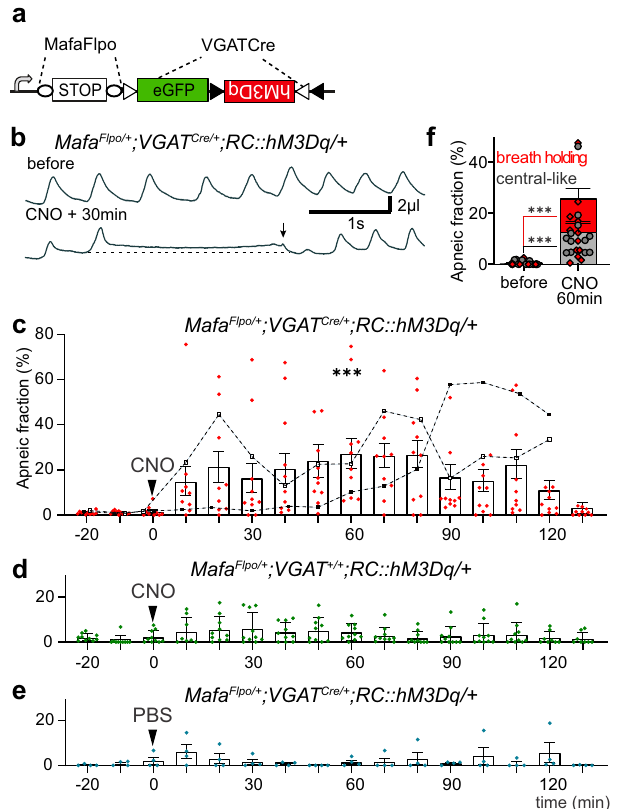
Fig. 6 Chemogenic activation of Mafa inhibitory neurons triggers apneas. a Genetic scheme to introduce the hM3Dq DREADD in Mafa + inhibitory neurons. b Plethysmographic traces of the ventilation of a P1 Mafa Flpo/ + ; VGAT Cre/ + ; RC::hM3Dq/ + pups before (top) and 30 min after a subcutaneous injection of CNO (5 mg/kg). Note the presence of a click-like upward pressure shift terminating the breath holding apnea. c Injection of CNO in P1-2 mutants caused a fi ve-fold increase of the apneic time fraction ( n = 12 pups, Two-way ANOVA comparing the CNO effect on mutants and on Cre + / + siblings P = 0.001, df = 1, F = 14.7). This effect was usually reversible ( n = 10/12 pups) but caused irreversible ( n = 2/12 pups) apneic breathing (black traces fi lled and empty symbols) followed by death brie fl y after. d , e Experimental controls showing no effects of CNO on Cre + / + pups ( d , n = 10 and no effect of saline (PBS) on mutant pups ( e , n = 4). f Quanti fi cation of the apneic time fraction of apnea types before and 60 min after injection of CNO showing signi fi cant increases for both types ( n = 12 pups; breath holding: two-sided Wilcoxon test P = 0.0005 and central-like: two-sided Wilcoxon test P = 0.0005). Plots represent mean ±